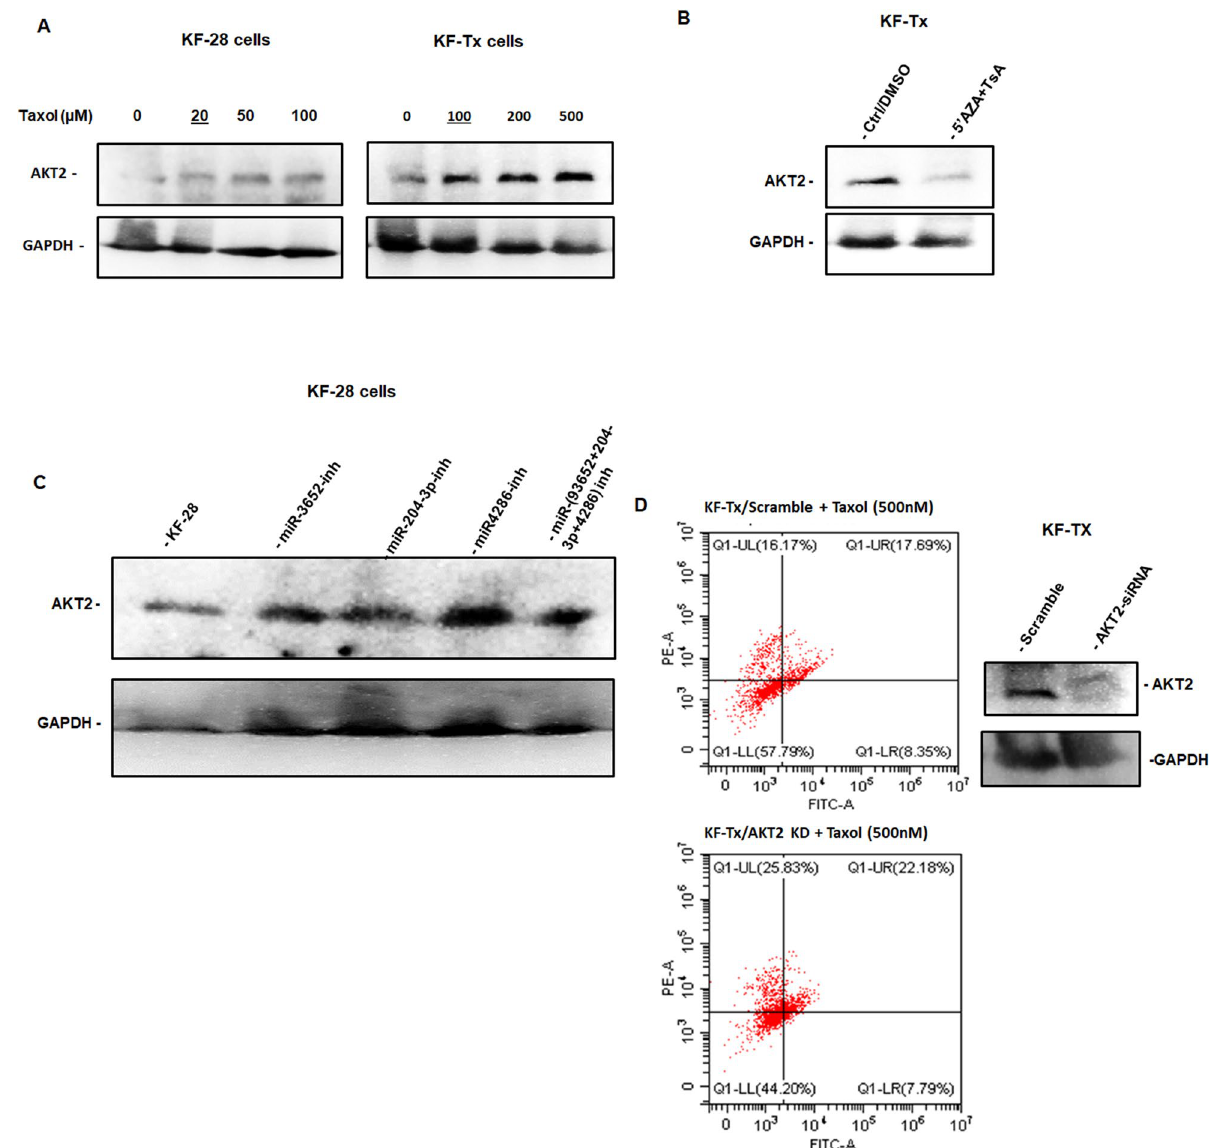
Figure 8. AKT2 expression mediates the response of KF-28 and KF-Tx and responses to epigentic modulators. ( A ) Western bloting result shows AKT2 expression in KF-28 and KF-Tx cells in response to PTX at the indicated concentrations. The underlined conc. Indicate the IC50 for each cell line. ( B ) Western bloting result indicating the downregulation of AKT2 in response to the combination of 5 ′ AZA and TsA in KF-Tx cells. ( C ) Western bloting result indicating the expression of AKT2 in the KF-28 parental cells transfected with each single miRNA inhibitor, mixture of the three miRNA inhibitors or scrambled RNA together. ( D ) right panel indicates the downregulation of AKT2 in response to specific siRNA compared with control siRNA in KF-Tx cells. The left panel is annexin/PI results show the relative sensitization of KF-Tx cells to PTX after AKT2 knock value that still lies within the clinically relevant treatment range. It is worth noting that this cell line has wild-type TP53 31–34 . A2780 cells line was gifted by Prof. Hidemich Watari, Graduate School of Medicine, Hokkaido Uni- versity, Japan as purchased from ECACC (ECACC 93112519). Both Cell lines were maintained in RPMI-1640 (Sigma-Aldrich, USA) supplemented with 2mML-glutamine (Lonza, Belgium) and 10% FBS (Sigma, St. Louis, MO, USA), 1% Penicillin/Streptomycin (Lonza, Belgium) at 37 °C in 5% CO2 atmosphere (NuAire). KF-Tx and A2780-Tx cells were established from parental cell lines, KF-28 and A2780, respectively, by maintaining them in increasing sublethal concentrations of PTX (up to10 nM) for more than 10 months. Detection of IC 50 for each clone by 3-days viability assay was determined and demonstrated that IC 50 of the KF-Tx cells showed almost eight-fold increase compared with the parental cells. For 5 ′ AZA and TsA treatment, cells were grown in 10 cm 2 culture dishes to a monolayer confluence of 70%. Cells were treated everyday with fresh media containing 10 µM 5 ′ AZA for three days while drug-containing media was replaced every day with the addition of 300 nM TsA in the third day followed by cell lysis or RNA purification.